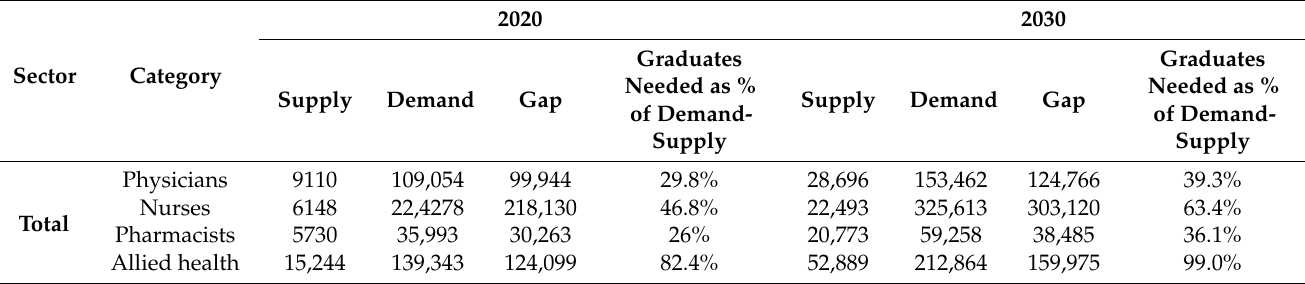
Table 2. Analysis of total demand and supply